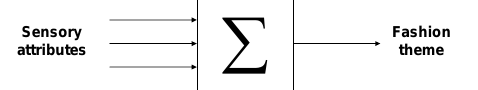
Fig. 2. The relationship between sensory attributes and one fashion theme